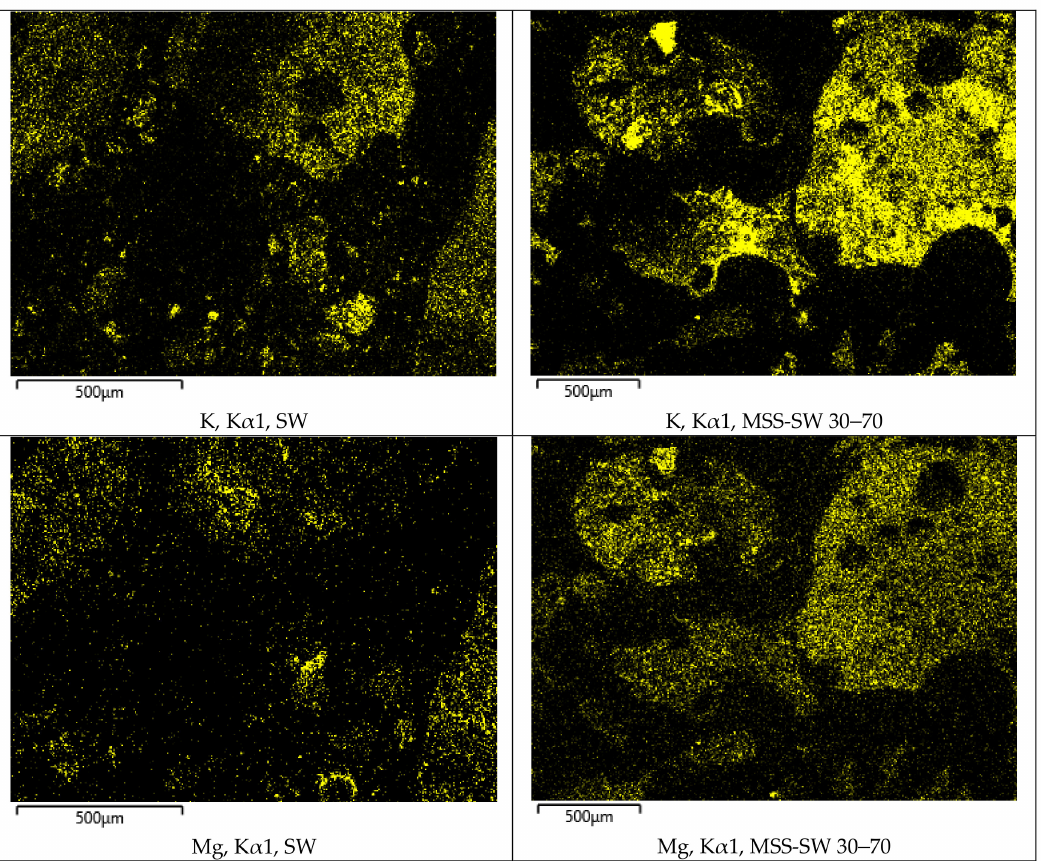
Figure 7. SEM-EDX images for ash samples SW and MSS-SW 30–70. Specific areas for P association analysis are marked with numbers in each electron